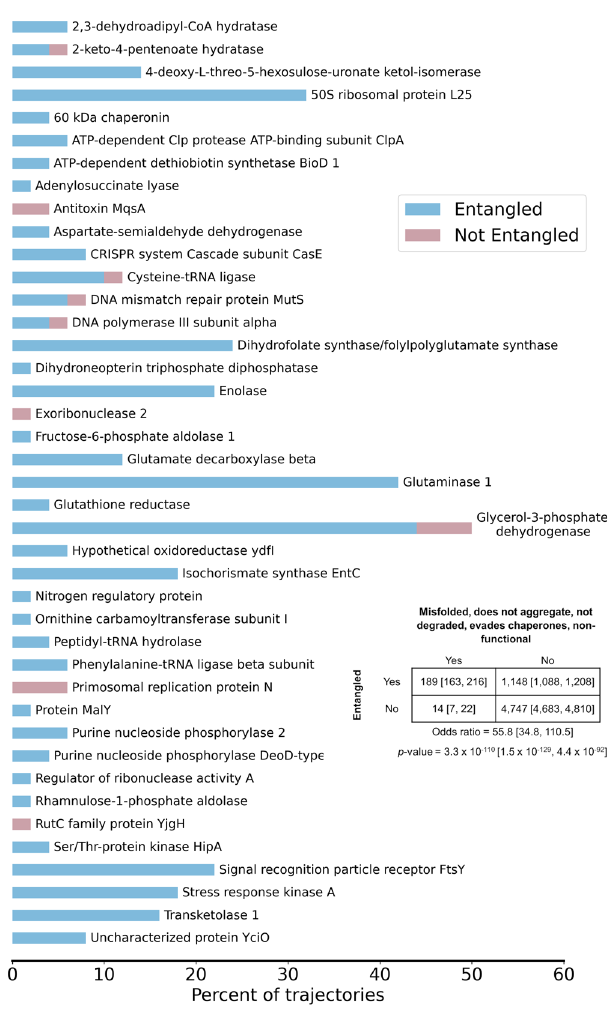
Fig. 4 The vast majority of trajectories predicted to bypass cellular quality controls and exhibit reduced function are entangled. The percent of trajectories out of 50 for each of the 41 proteins that bypass quality controls and are predicted to have reduced function that are entangled (blue) or not entangled (red). A total of 189 out of 203 trajectories are entangled. Protein names were taken from UNIPROT; see Supplementary Table 2 for the structures used and their corresponding gene names. Inset contingency table indicates the number of trajectories that are misfolded and escape proteostasis machinery while remaining non-functional and entangled/not entangled. Indicated p -value and odds ratio were computed in SciPy using the Fisher Exact Test. All error bars are 95% con fi dence intervals from bootstrapping 10 6